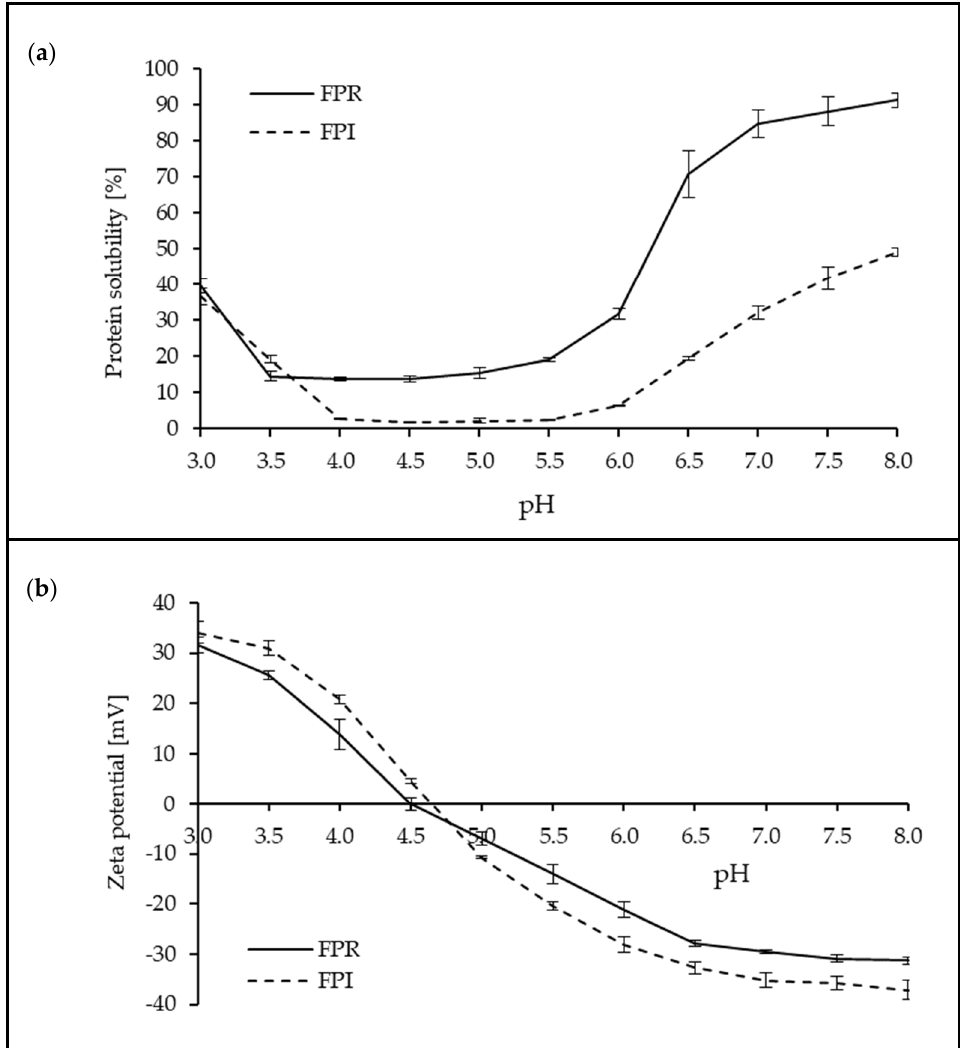
Figure 4. Protein solubility (%) ( a ) and zeta potential (mV) ( b ) as a function of pH for FPR and FPI (error bars show + one standard